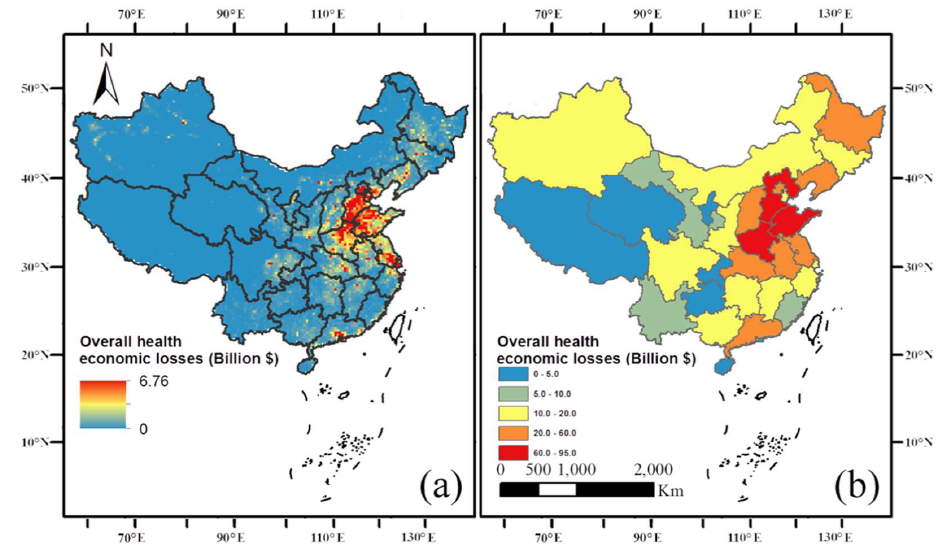
Figure 6. Overall health economic losses based on remote sensing data ( a ) and in-situ data (b).